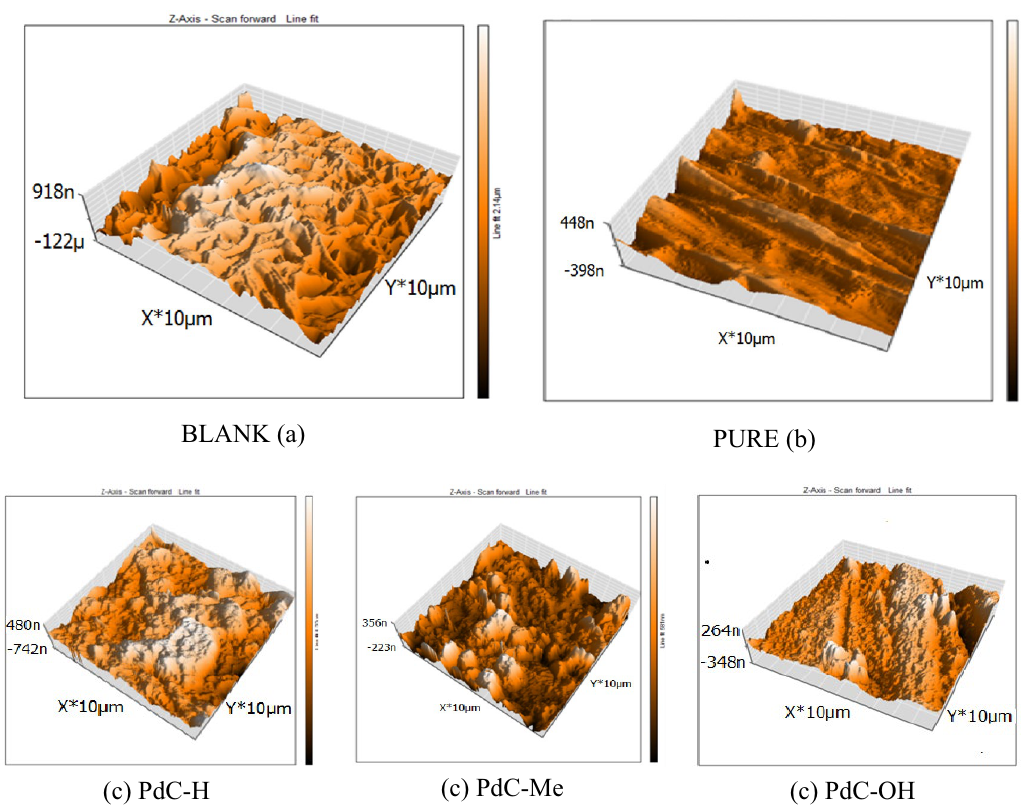
Figure 13. AFM images for uninhibited ( a ), pure ( b ) and inhibited carbon steel ( c ) after immersion for 24 h in 1 M HCl with (PdC-H, PdC-Me and PdC-OH) compounds.